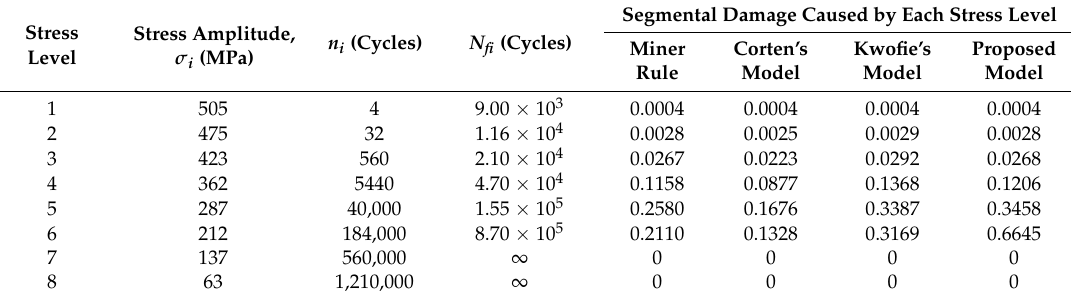
Table 5. Experimental data and the predicted damage for CFD1 test.